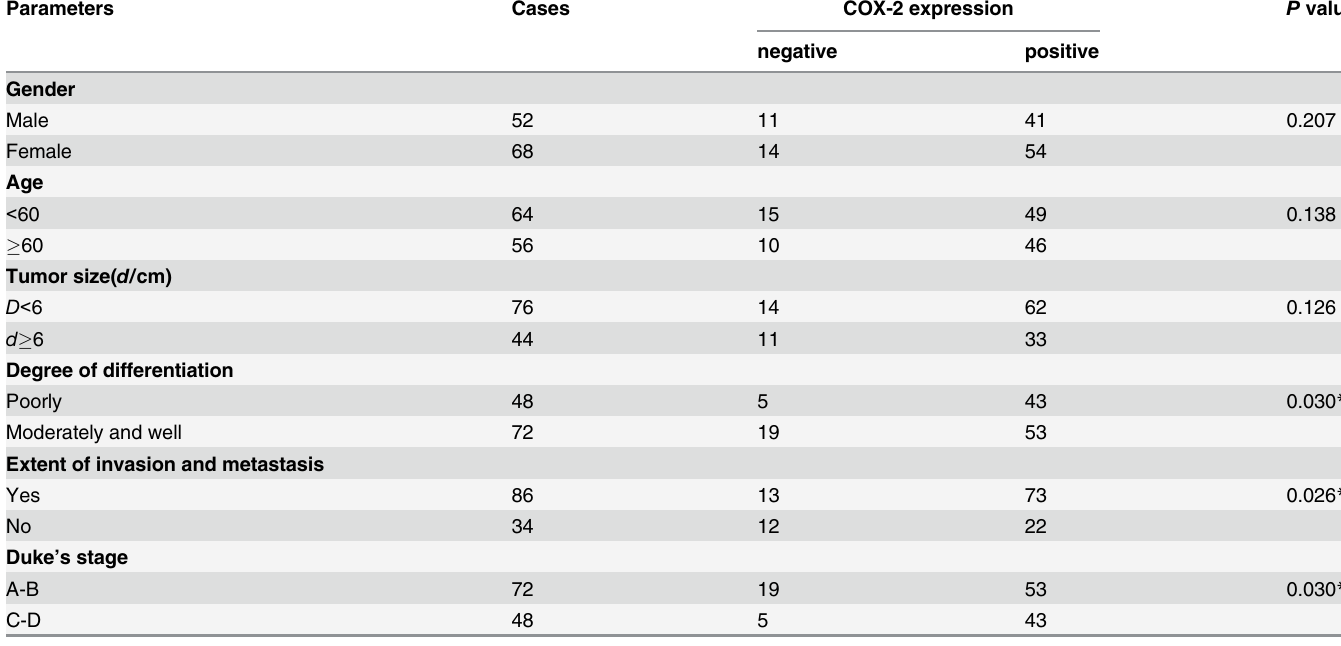
Table 3. Clinicopathologic correlation of p-STAT3 in human